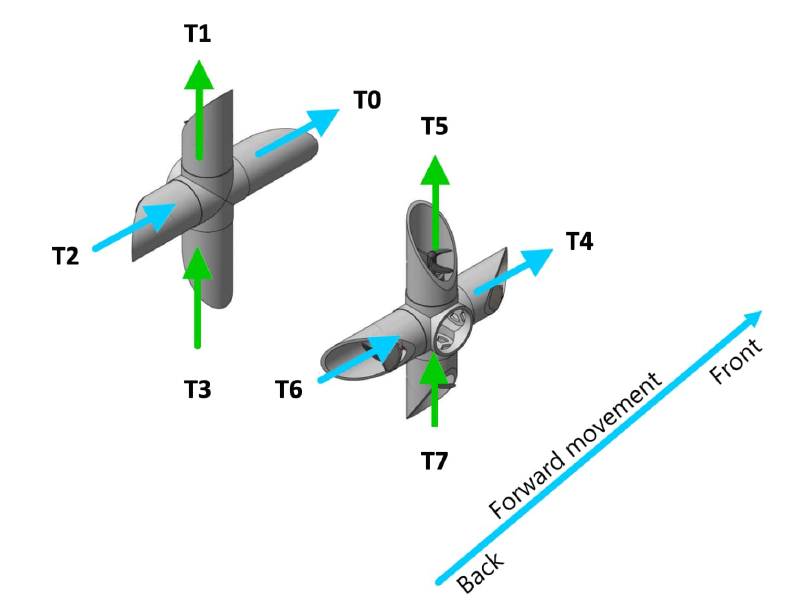
Figure 4. Thrusters allocation, the green arrows represent the thrusters implicated on heave move- ment ( T 1 , T 3 , T 4 and T 7 ) and the blue ones, the thrusters responsible of forward movement ( T 0 , T 2 , T 4 and T 6